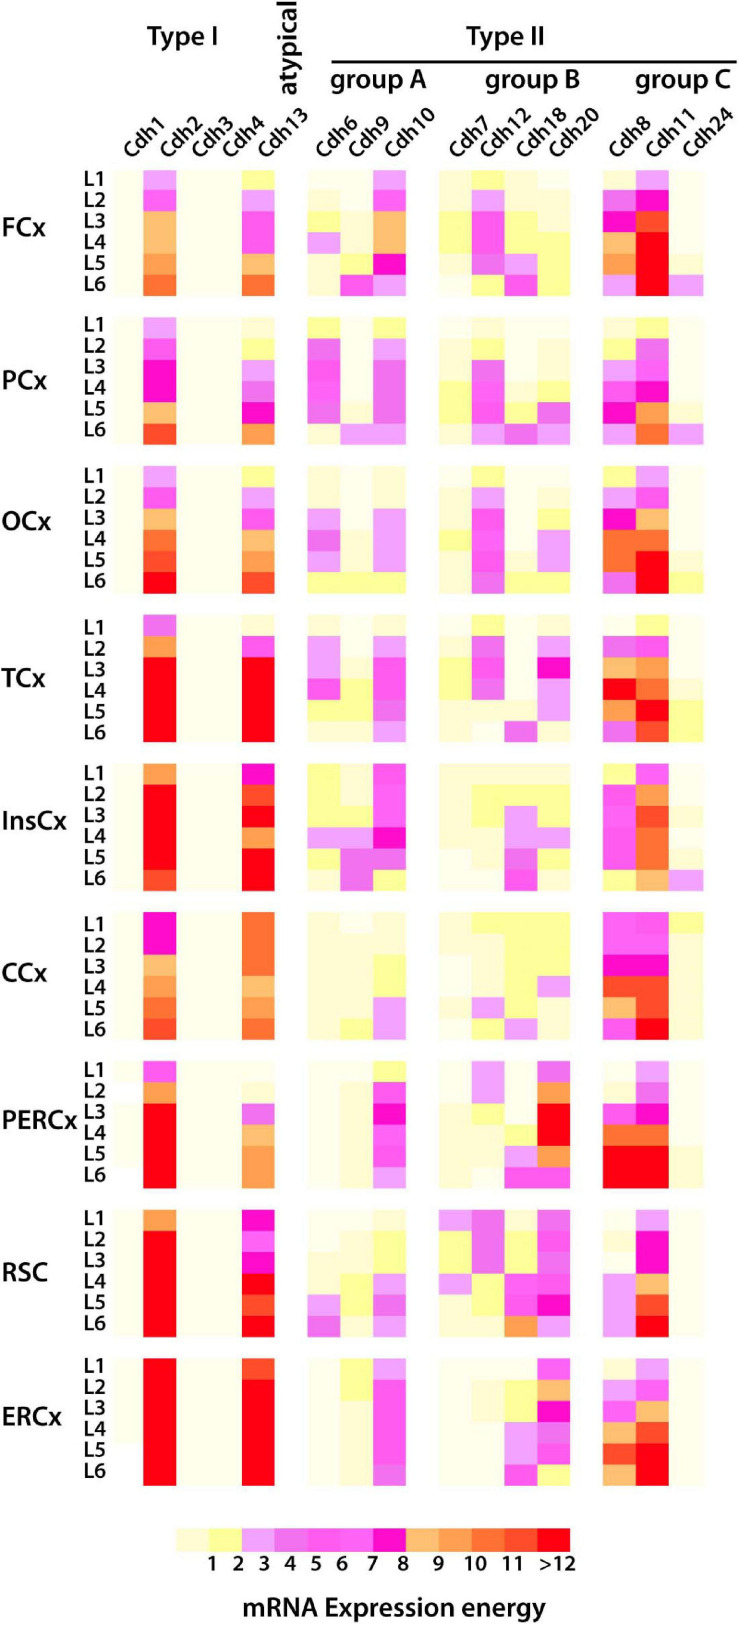
mRNA expression of type I and type II cadherins and the atypical Cdh13 in the cortical layers of the dorsal pallium (isocortex) in the young adult mouse (P56) from ISH experiments. The heatmap displays cadherins mRNA expression energy in each layer of the nine cortical areas detected by ISH. The superficial layer 1 (L1) is at the top, and the deeper layer 6 (L6) is at the bottom. FCx, frontal cortex; PCx, parietal cortex, OCx, occipital cortex; TCx, temporal cortex; InsCx, insular cortex; CCx, cingulate cortex; PERCx, perirhinal–ectorhinal cortex; RSCx, retrosplenial cortex; ERCx, entorhinal cortex.